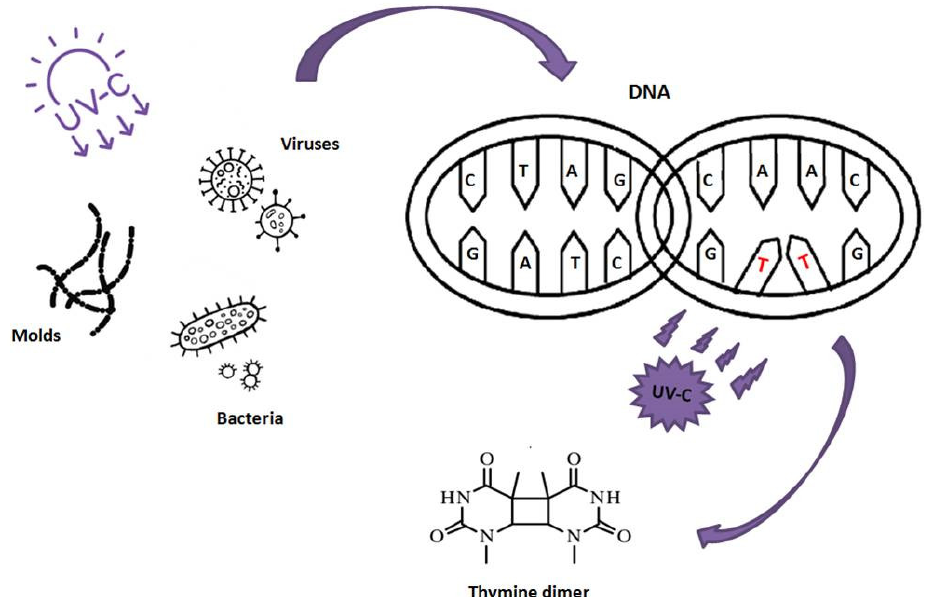
Figure 2. Genetic damage by UV-C rays.